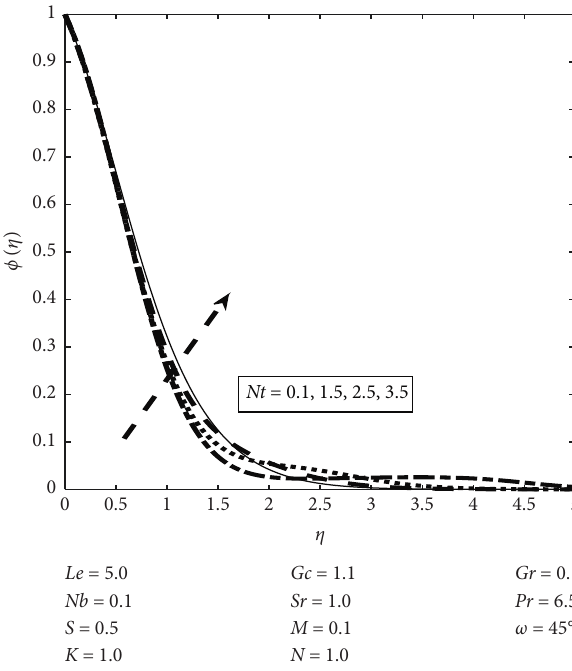
Figure 16: Concentration profile for several values of Nt